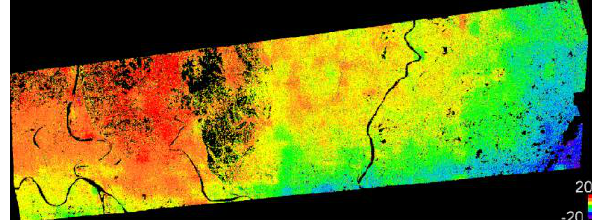
Figure 19. Footprints of a CORONA stereo pair